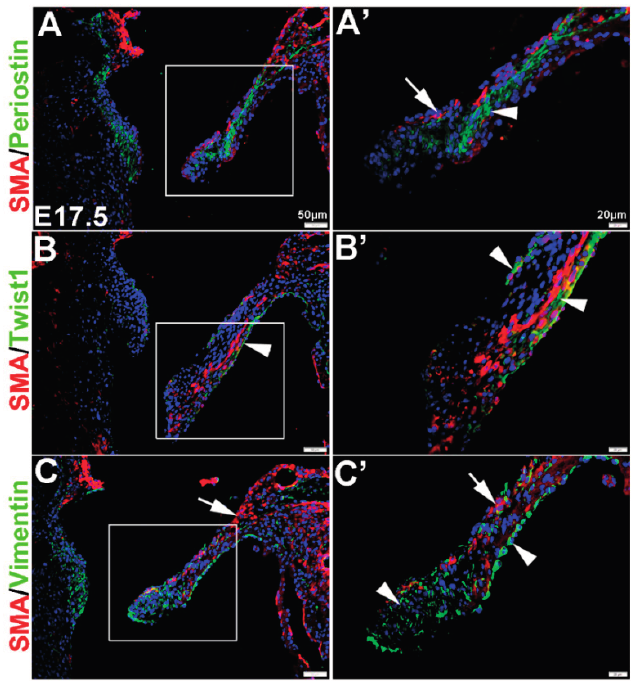
Figure 2. Characterization of VIC phenotypes in remodeling mitral heart valve structures. Immunohistochemistry to show expression of smooth muscle α -actin (SMA) with Periostin ( A , A’ ), Twist1 ( B , B’ ) and Vimentin ( C , C’ ) in cells within the elongating mitral valve leaflet (mural). Arrows indicate SMA expression (red) and arrowheads indicate Periostin ( A , A’ ) Twist1 ( B , B’ ) and Vimentin ( C , C’ ) shown in green. The boxed areas in A-C are shown at higher magnification in ( A’ – C’